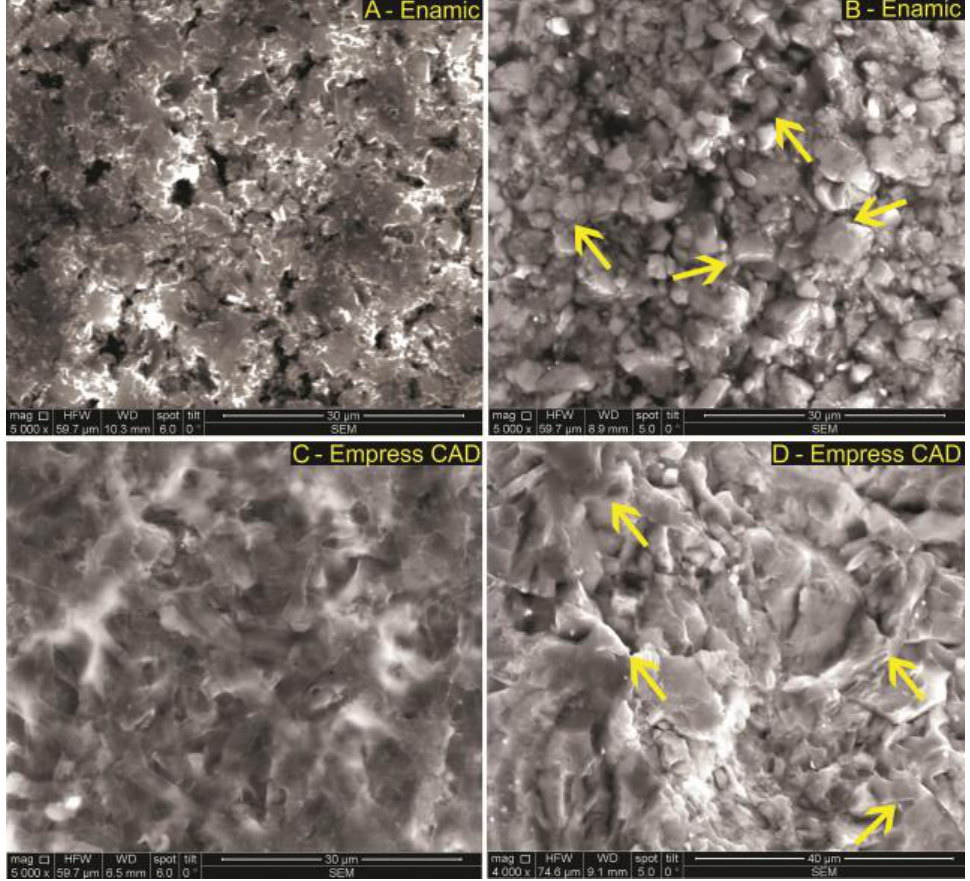
Figure 5. SEM images of Enamic and Empress CAD ( A , C ) — before and ( B , D ) — after exposure to simulated gastric acid Scheme 5000× magnification and a 59.7 – 74.6 µm horizontal field width. The simulated gastric acid Scheme 5000 × magnification and a 59.7–74.6 µ m horizontal field width. The yellow arrows represent the changes that occurred after simulated gastric acid exposure. yellow arrows represent the changes that occurred after simulated gastric acid